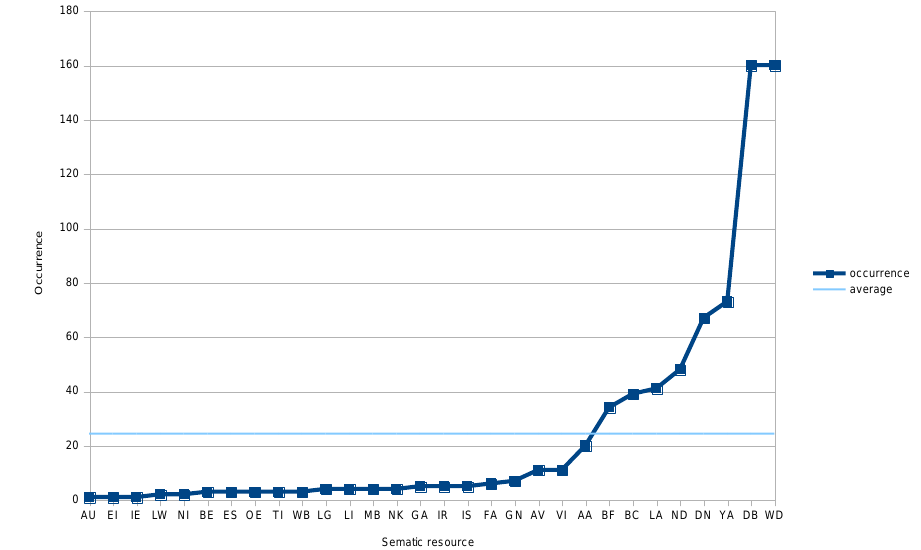
Figure 4. Occurrence of the tested concepts and objects in semantic resources.